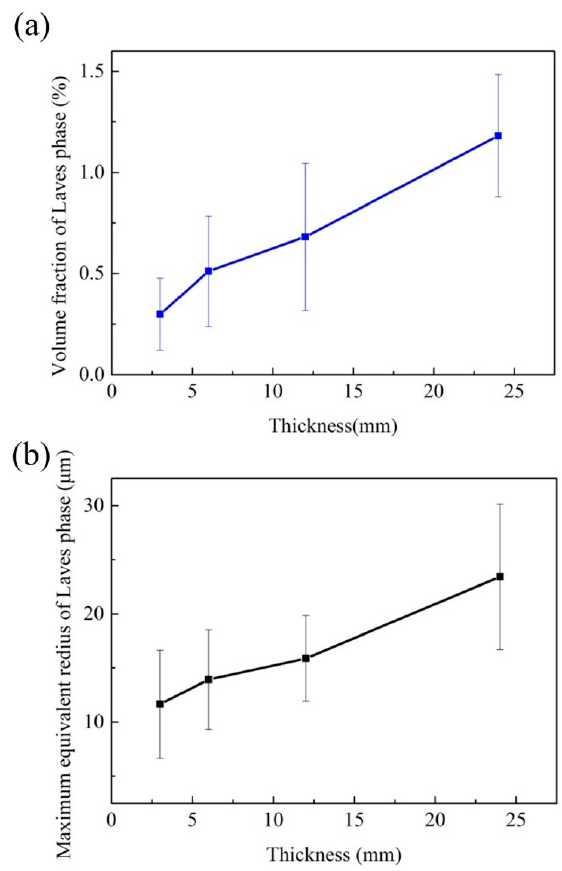
Figure 7. ( a ) The volume fraction and ( b ) the maximum equivalent radius of the Laves phase with different wall thicknesses.